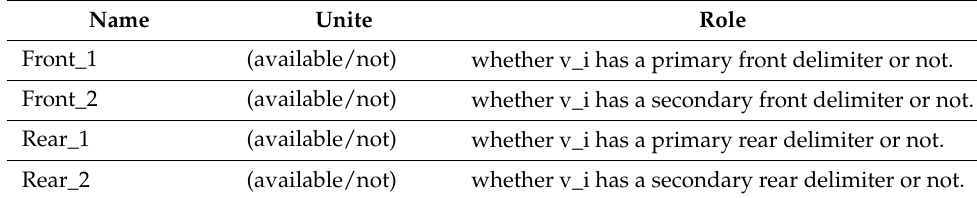
Table 3. The used terminologies in OVR for the boolean